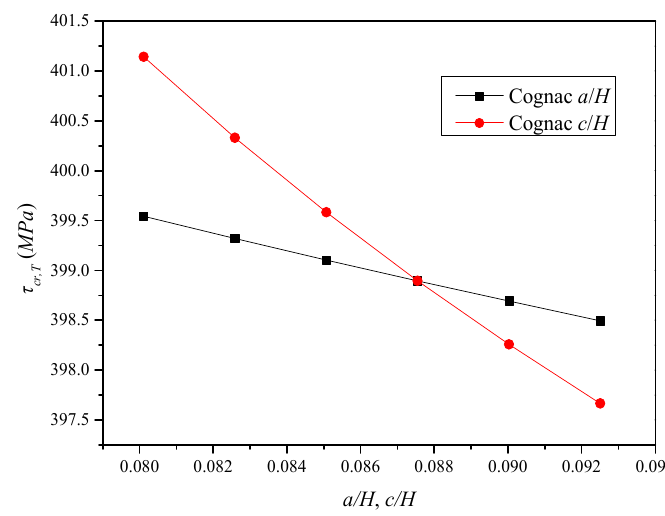
Figure 9. Global elastic shear buckling strength in theory τ cr,T versus the ratios a / H and c / H ( R = 110 m, H = 4032 mm).